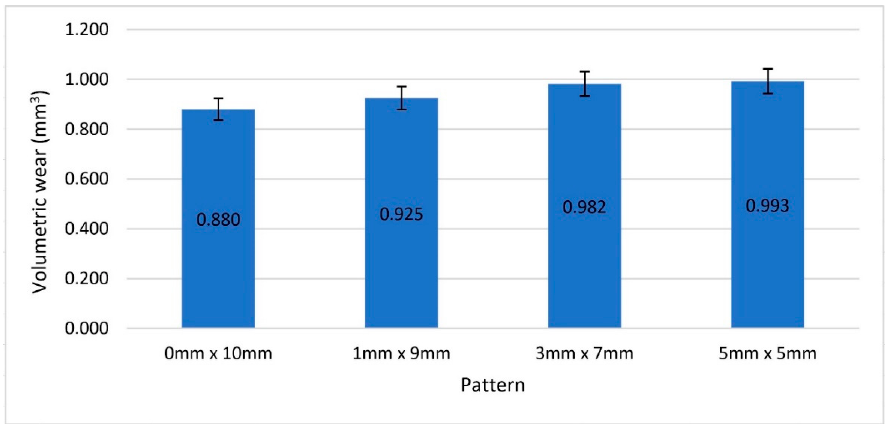
Figure 11. Mean volumetric wear of Ti-6Al-4V ELI alloy discs tested over 5000 cycles against alumina balls using Ringer’s solution as